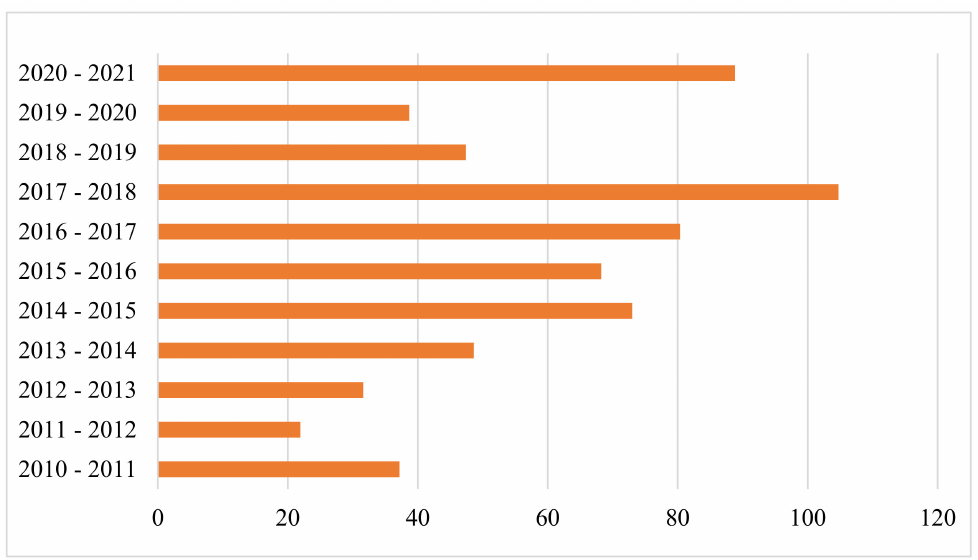
Figure 12. PSO levy for residential users in Ireland during 2010–2021, EUR per year including VAT (designed by the authors based on